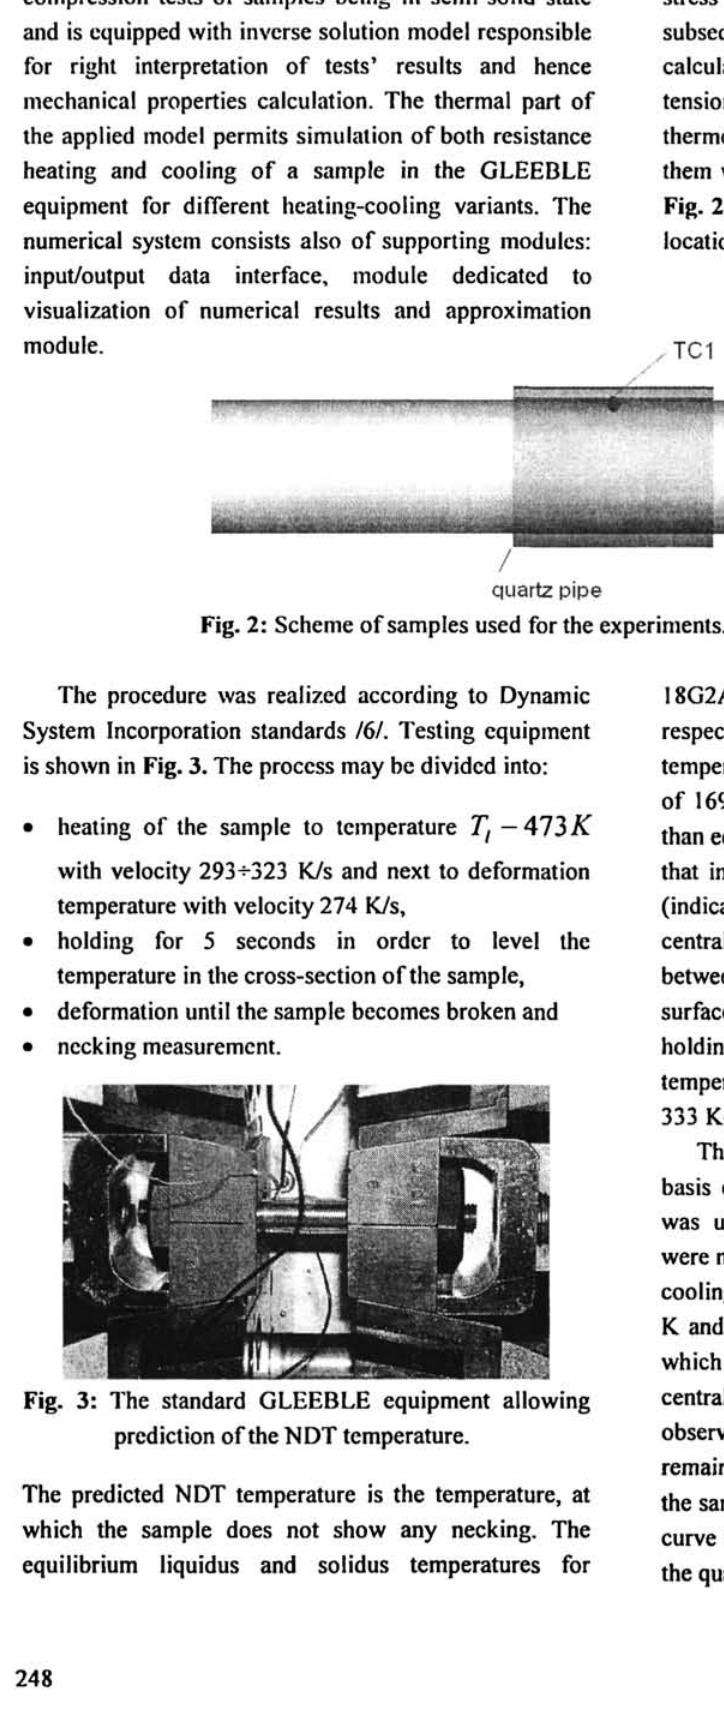
Fig. 3: The standard GLEEBLE equipment allowing prediction of the NOT